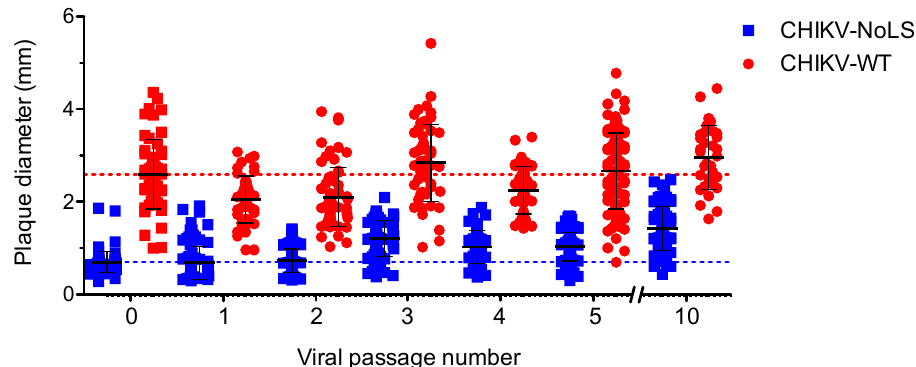
Figure 4. CHIKV-NoLS plaque size after extended in vitro passage. CHIKV-NoLS and CHIKV-WT were passaged 10 times in Vero cells at 37 °C using a multiplicity of infection of 0.1 PFU/cell. With each passage of virus, Vero cells were infected with 30 PFU and plaque size measured using ImageJ software. Each dot represents one plaque. Dashed lines represent the mean plaque size for CHIKV-NoLS and CHIKV-WT at passage 0.